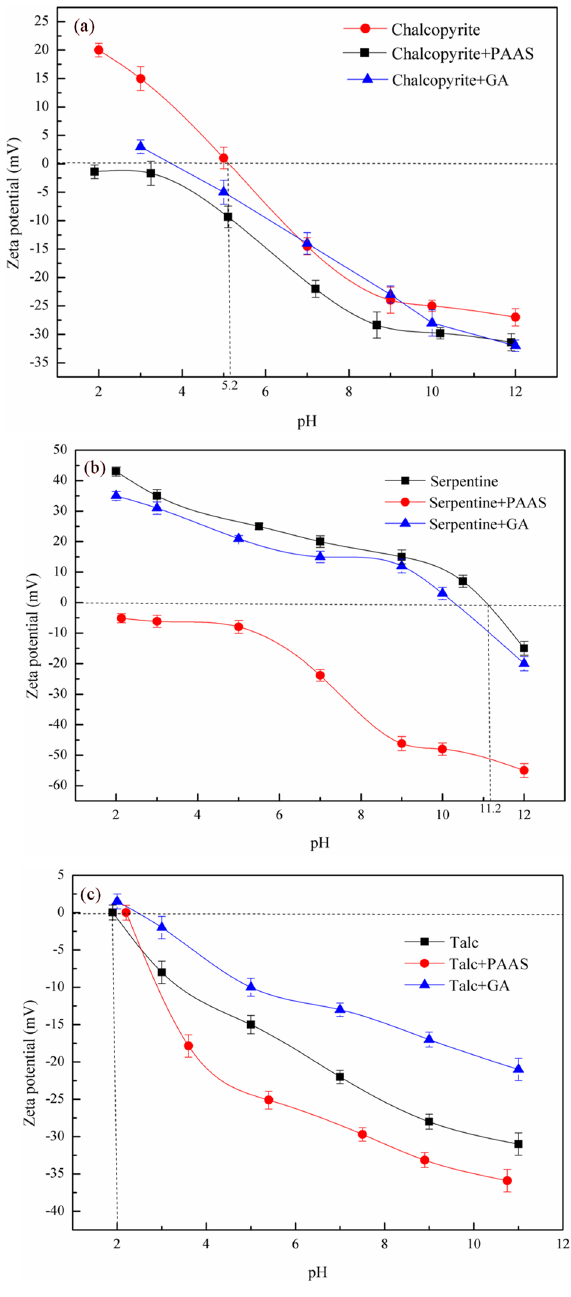
Figure 7. Zeta potentials of chalcopyrite ( a ), serpentine ( b ), and talc ( c ) at the different pH before and after reacting with PAAS and GA, c(PAAS) = 24.7 mg/L, c(GA) = 100